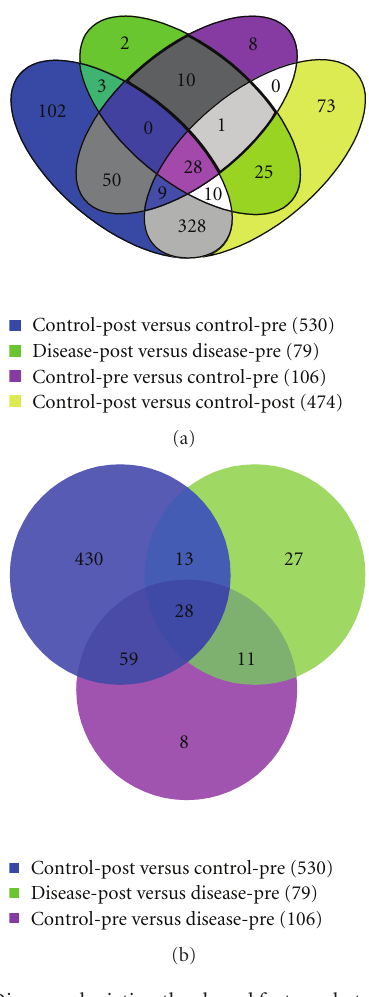
Figure 11: Diagram depicting the shared features between di ff erent sets of ratio data. The features in an individual set are those that displayed a significant change in intensity between the two members of the ratio. (a) All four samples, (b) the three ratios used to extract the RP candidates from the overlaid: control-pre to control-post, disease-pre to disease-post, and control-pre to disease-pre. Eleven features uniquely associated to a hypersensitive reaction as well as di ff erential between patients before treatment. Figure 12: Visualization of the candidate 11 features for RP (a) PCA and (b) MDS. Note the separation between control-pre and disease-pre and disease-post and disease-pre as anticipated from the experimental design strategy we followed to extract these